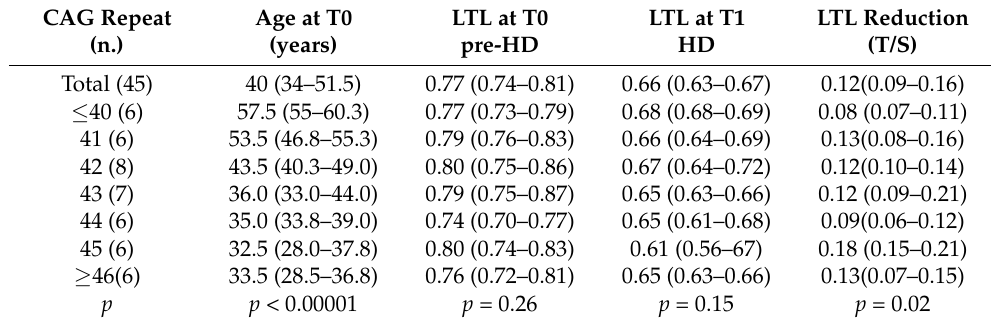
Figure 3. LTL values as a function of CAG number in patients. Box plots showing the distribution of LTL expressed as a relative telomere length T/S ratio: ( a ) at baseline (pre-HD stage) ( p = 0.26); ( b ) at follow-up (manifest HD stage) ( p = 0.15). Groups are compared with Kruskal–Wallis test. Table 2. Distribution of median LTL (T/S) in HD patients carrying different CAG repeat numbers at baseline (T0) and at follow-up (T1). Values are reported as median